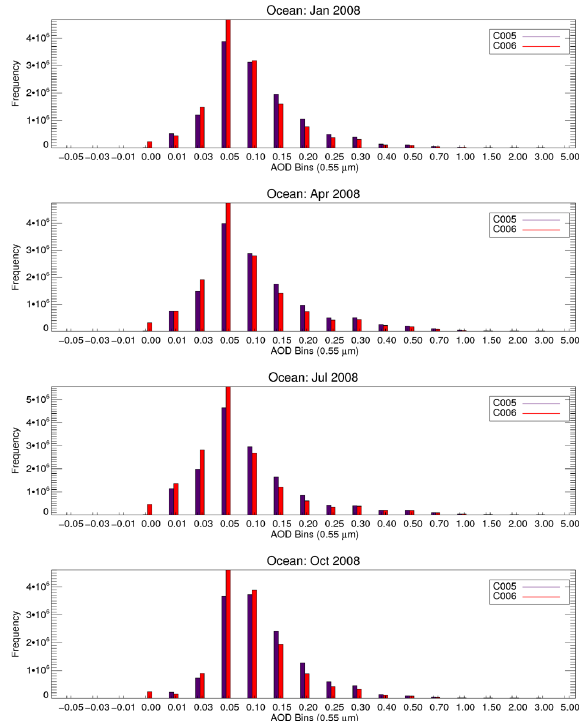
Fig. 14. Histograms for global retrieved Level 2 DT-ocean AOD (at 0.55µm) from Aqua for four months. Plotted are data from C5 and